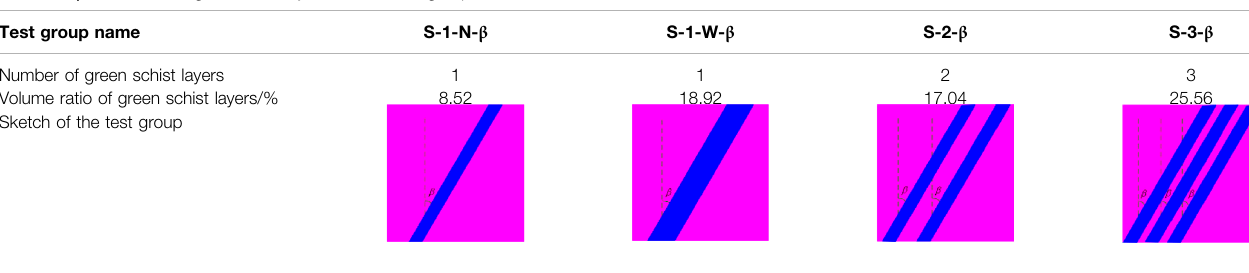
TABLE 1 | Information of greenschist layers in each test